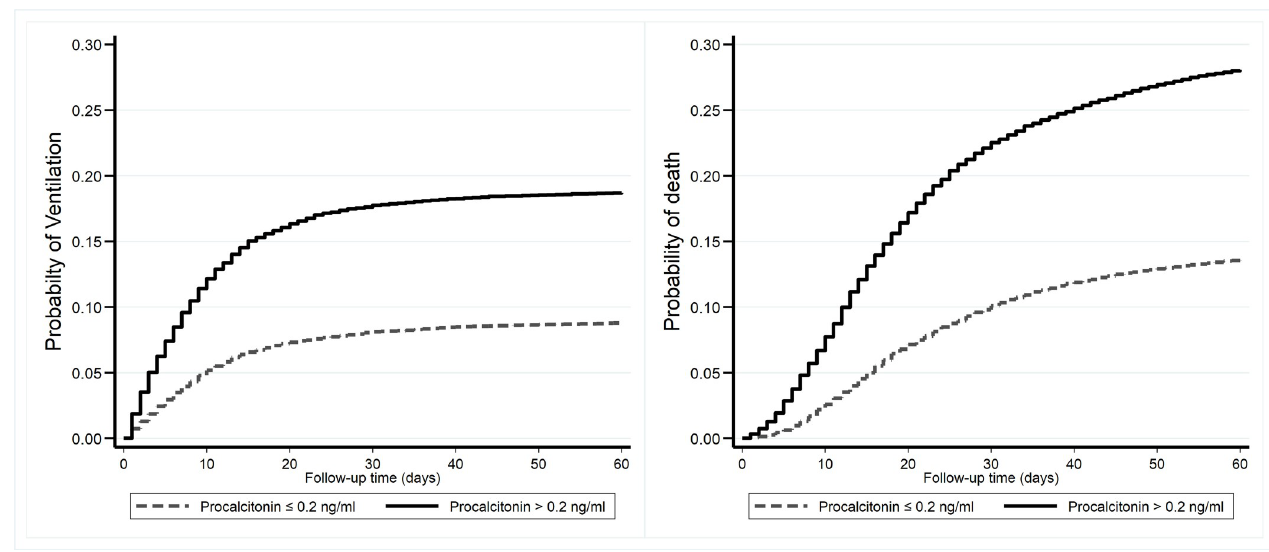
Fig 4. Kaplan–Meier plots for the probability of mechanical ventilation use (A) survival (B) for PCT > 0.2 ng/ml (solid black lines) and PCT � 0.2ng/ml (broken black lines).